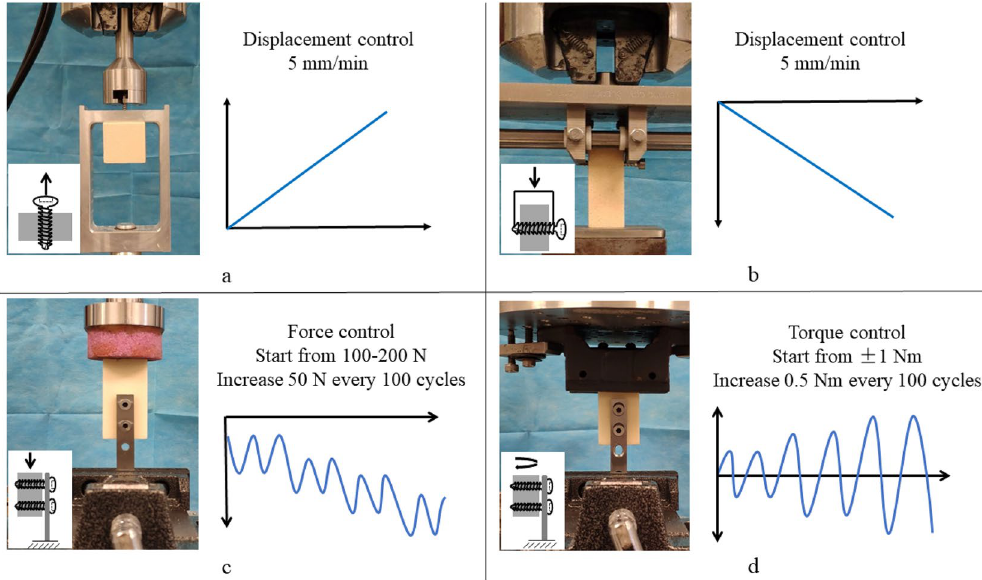
Figure 2. Experimental setups used in this study. ( a ) Individual screw axial pullout test; ( b ) individual screw lateral migration test; screw stability of plate fixation test under ( c ) craniocaudal loading and ( d ) torsional